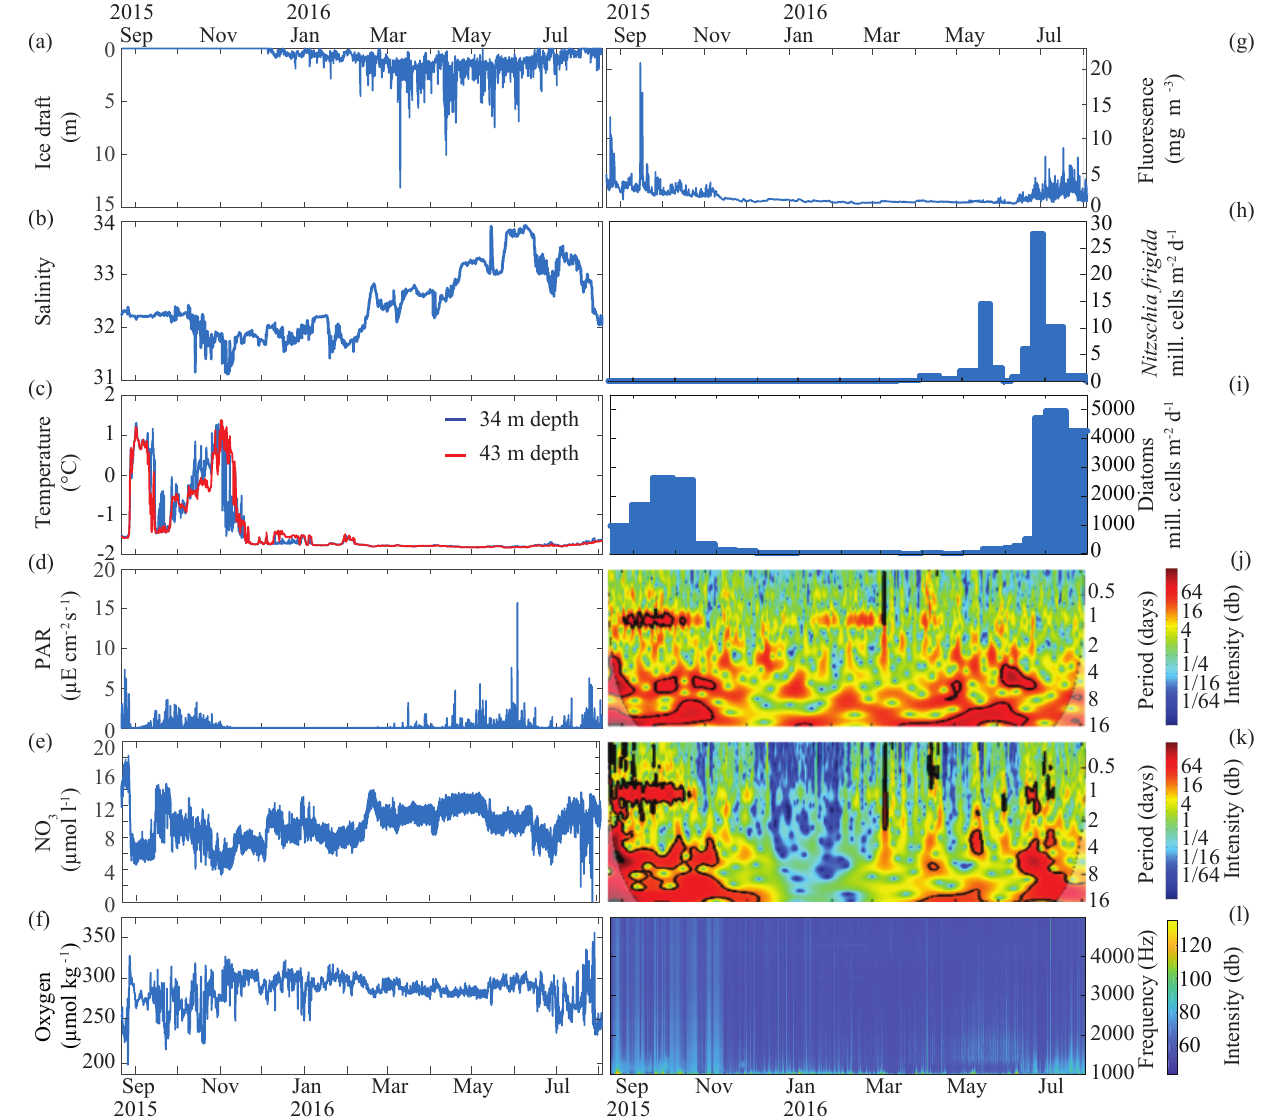
Figure 6. Data from the 2015/16 deployment. Shown are (a) ice draft (m), (b) salinity, (c) temperature ( ◦ C), (d) photosynthetically active radiation (PAR, µEcm − 2 s − 1 ), (e) nitrate (NO 3 , µmolL − 1 ), (f) oxygen (O 2 , µmolkg − 1 ), (g) fluorescence (mgm − 3 ), Nitzschia frigida flux (millioncellsm − 2 d − 1 ), (i) diatoms (millioncellsm − 2 d − 1 ), (j) acoustic zooplankton fish profiler (AZFP, days) 125KHz, (k) AZFP 38KHz (days), and (l) acoustic spectra (Hz). In situ NO 3 water samples were collected at times of the CEO deployment and recovery and were analyzed with standard wet chemical determinations of nitrate + nitrite of frozen samples at the Chesapeake Biological Laboratory. Using the calibration samples as anchor points, a drift of 12µmolL − 1 throughout the deployment was found and corrected by linearly detrending the